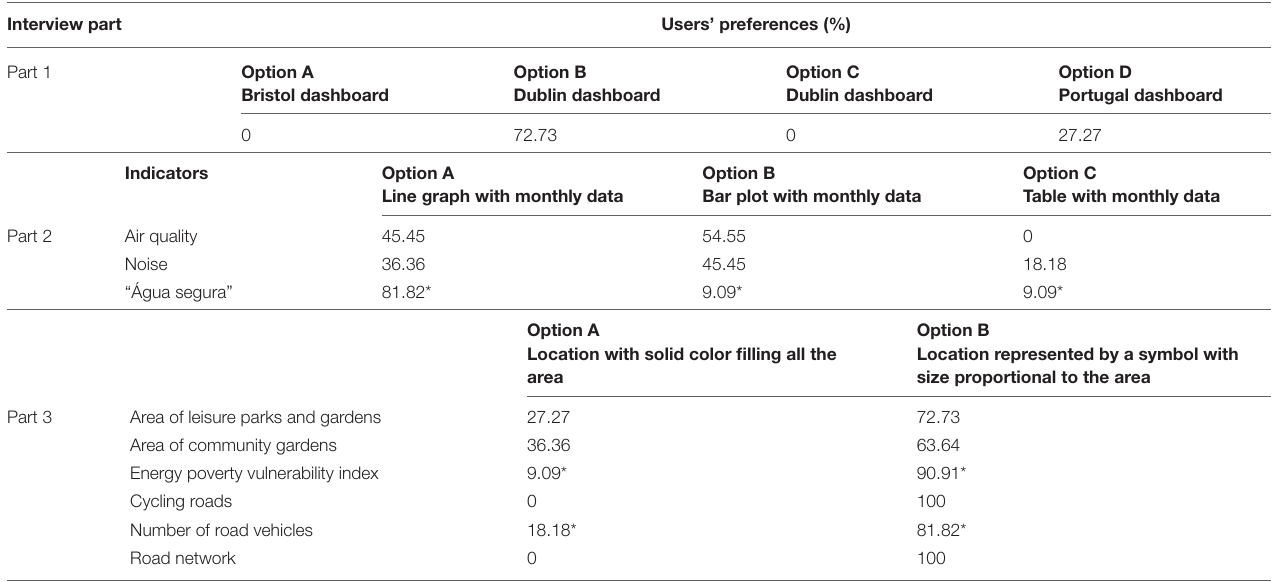
TABLE 1 | User’s preferences for each part of the semi-structured interview.